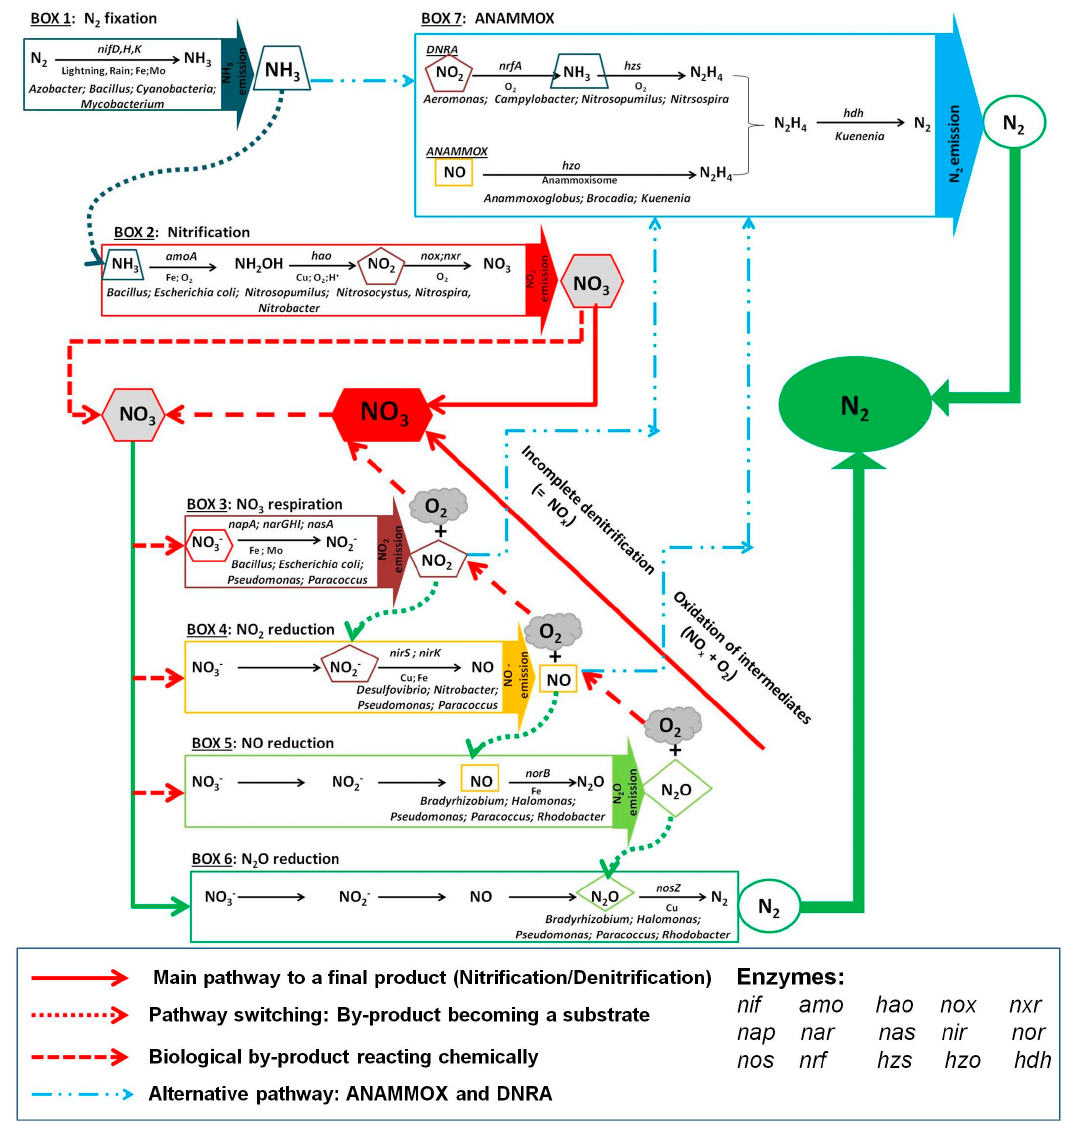
Figure 3. Biochemical pathways involved in the microbial nitrogen cycle facilitated by inherent enzymes and their co-factors.